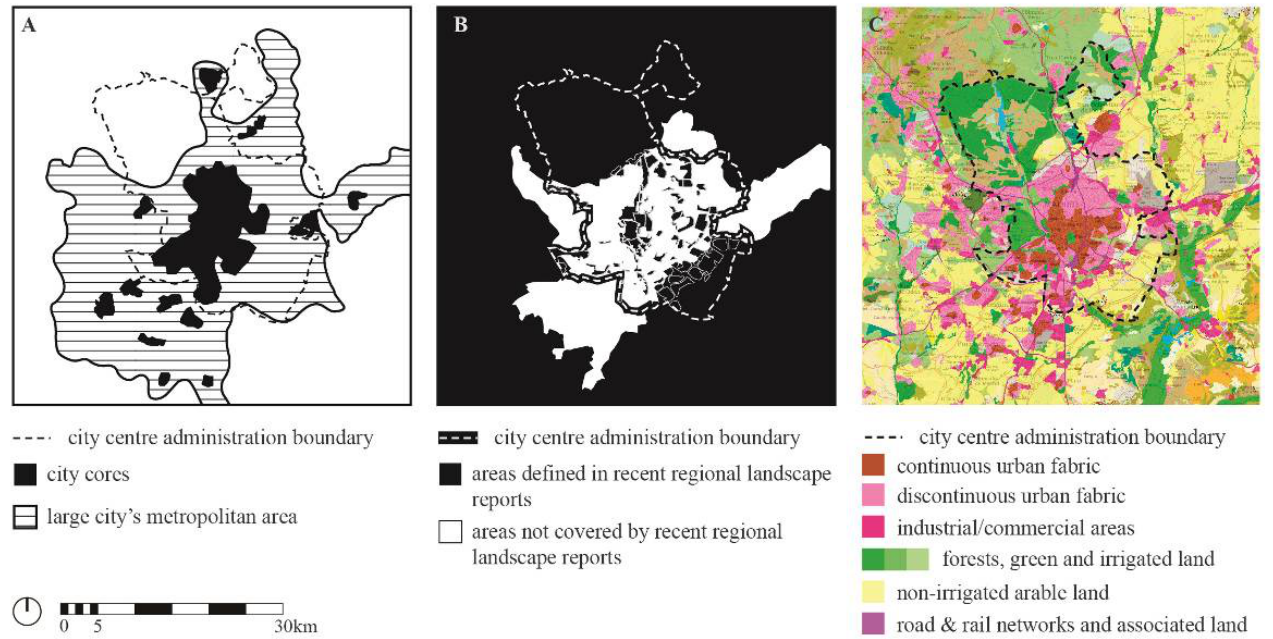
Figure 2: Previous landscape studies and land use cover for Madrid and its surroundings (A: Atlas of Spanish Landscapes, 2010; B: overlapping of areas covered in urban landscape report by Madrid’s city Council in 2009 and in the natural landscape report by the Autonomous Community of Madrid, 2007; C: land use cover,